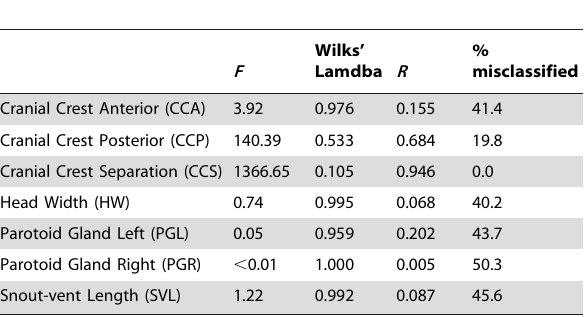
Table 1. Discriminant analysis of morphological characters.